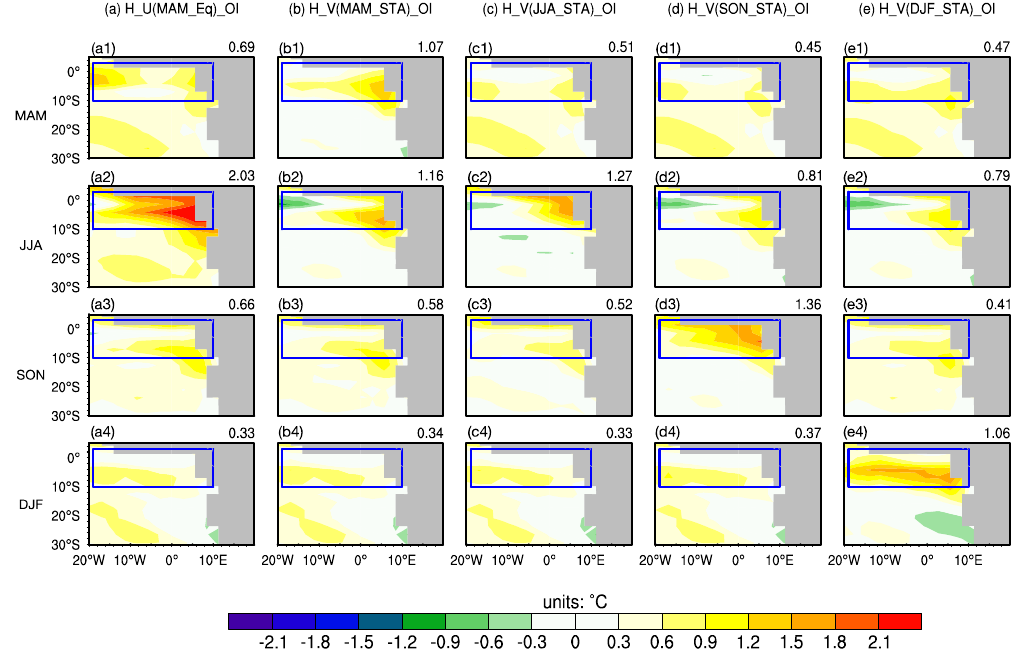
Figure 8. The same as in Figure 7, but for H_U(MAM_Eq)_OI ( a ); H_V(MAM_STA)_OI ( b ); H_V(JJA_STA)_OI ( c ); H_V(SON_STA)_OI ( d ); and H_V(DJF)_OI ( e ).